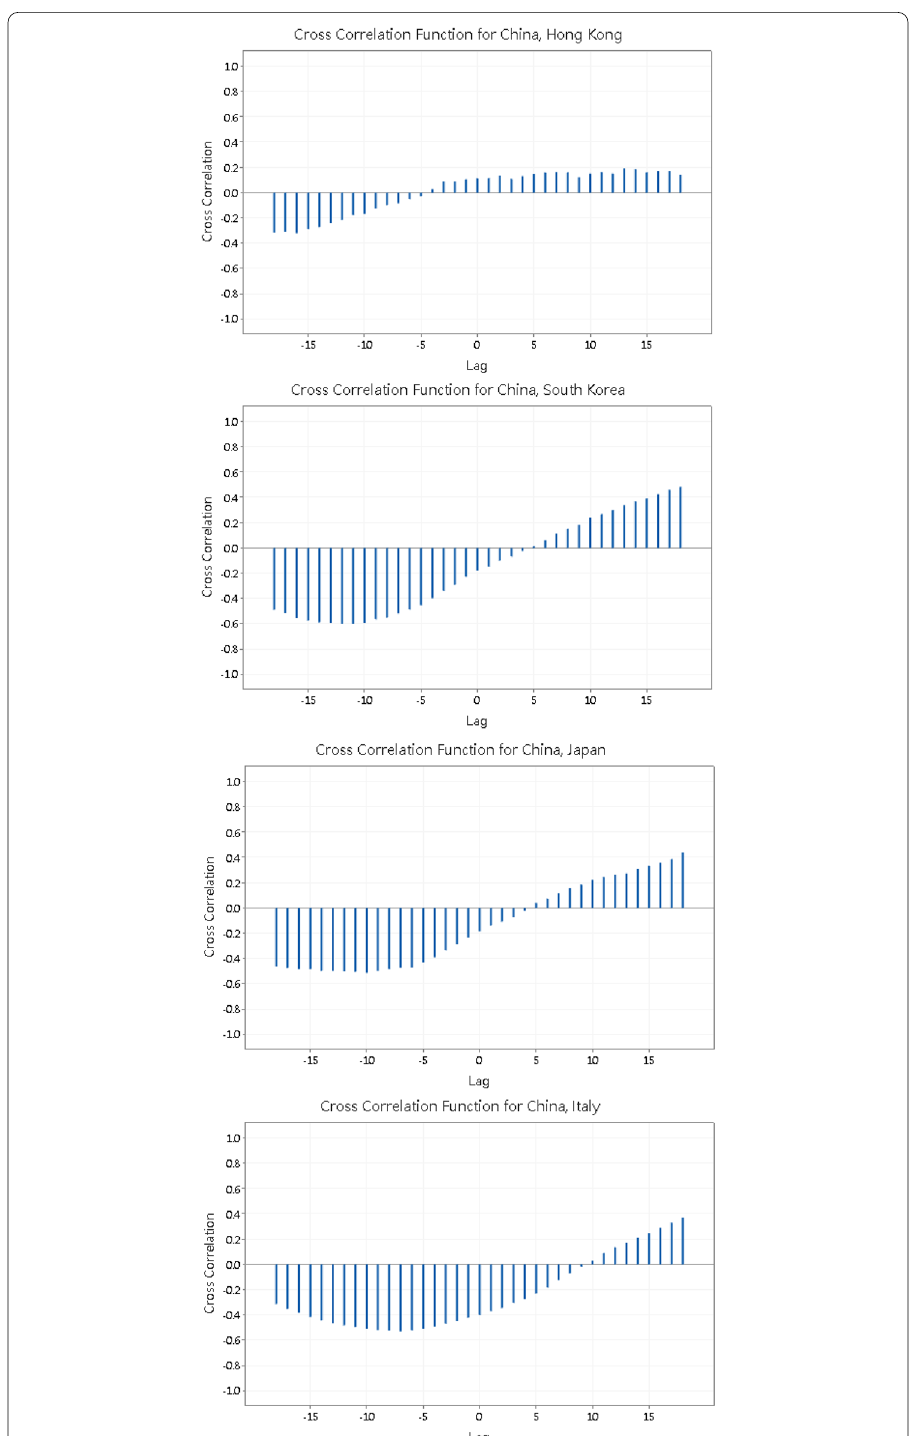
Fig. 2 The cross correlation function between